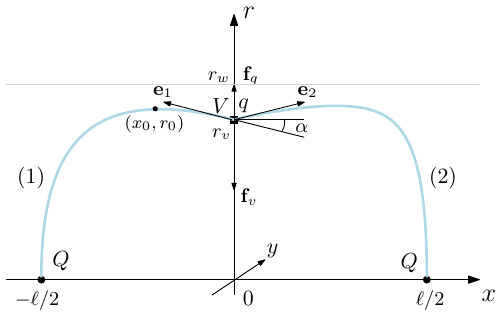
√ s . The arrows indicate the forces applied at the